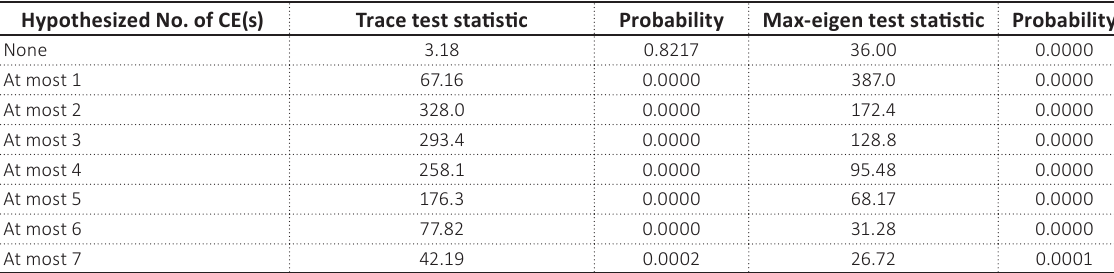
Table 2. Panel co-integration using the Johansen Fisher